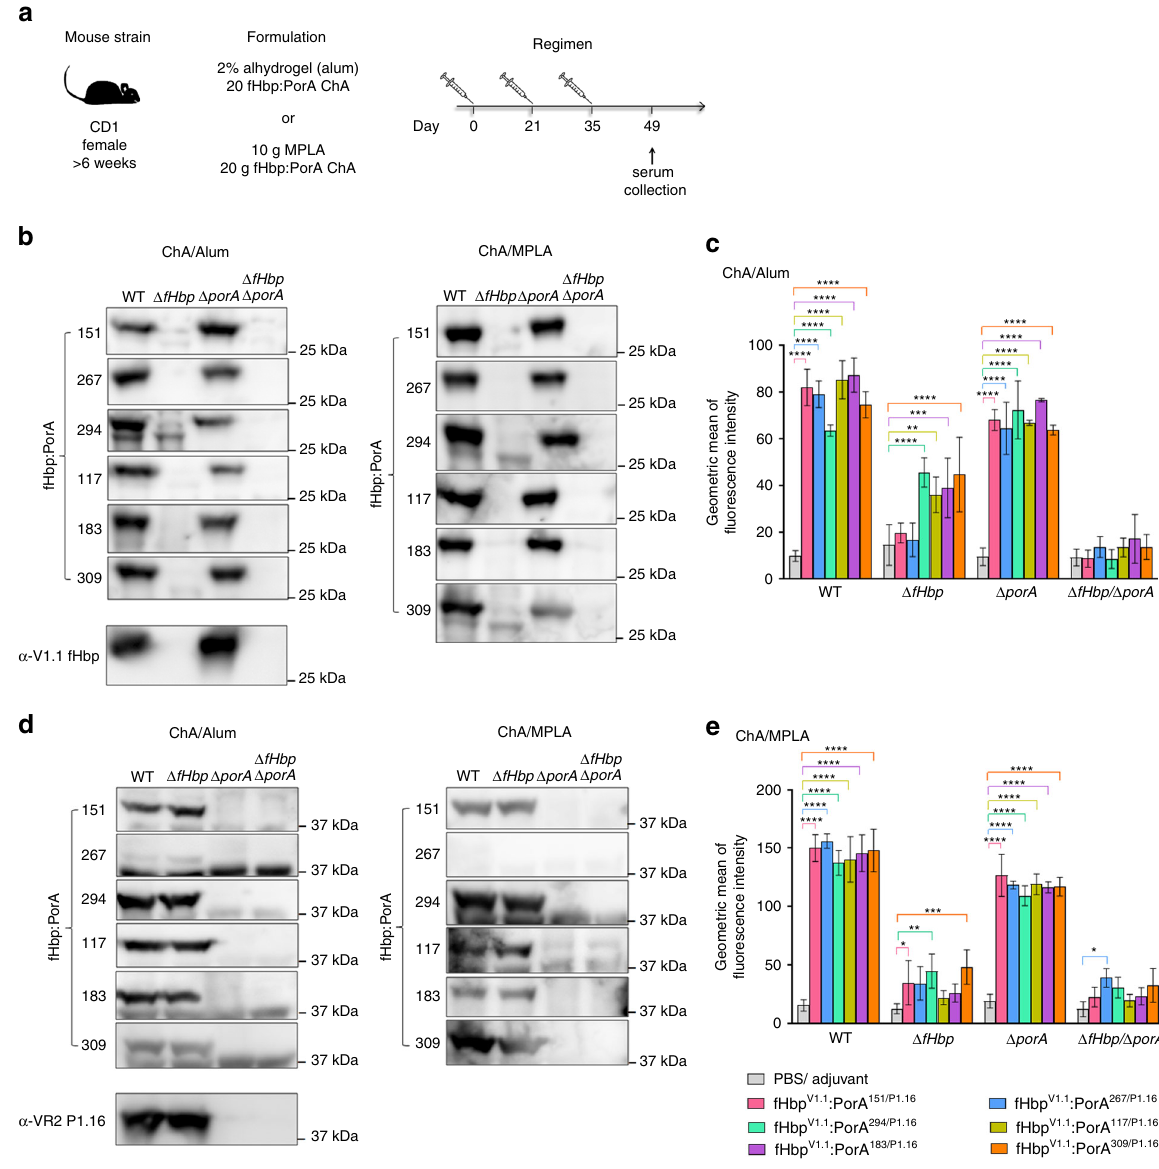
Fig. 2 Detection of fHbp and PorA by ChA antisera. a Immunisation strategy. Mice ( n = 8 per group) were subcutaneously immunised three times with each combination of ChA/Adjuvant. b , d Western blots of N. meningitidis whole-cell lysates probed with each set of ChA/adjuvant antisera: b detection of fHbp, d detection of PorA, complete western blots are in Supplementary Figures 6 and 7. c , e Flow cytometry analysis showing binding of each set of ChA/adjuvant antisera to N. meningitidis H44/76 strains WT, Δ fHbp , Δ porA and Δ fHbp Δ porA . s.d. of independent assays ( n = 3) is indicated. Two- way ANOVA and Dunnett ’ s method of multiple comparison were used to compare the fl uorescence intensity of ChA antisera with PBS control sera ( c , e * p ≤ 0.05, ** p ≤ 0.01, *** p ≤ 0.001, **** p ≤